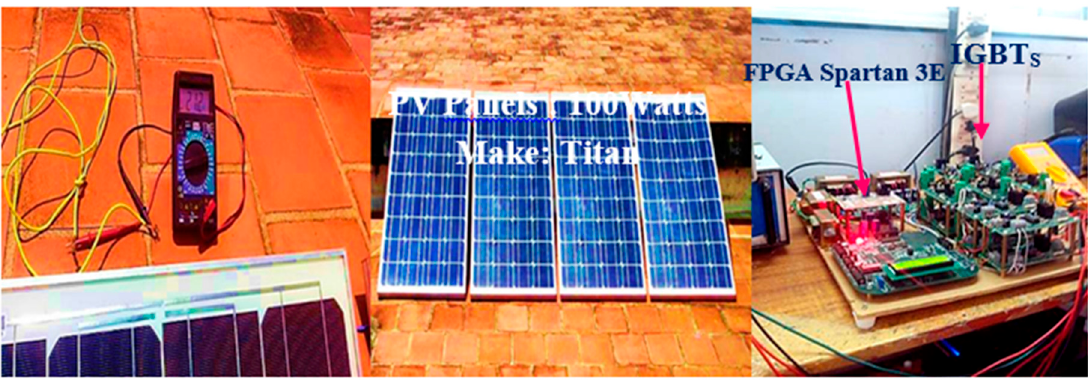
Figure 14. Photograph of experimental setup.